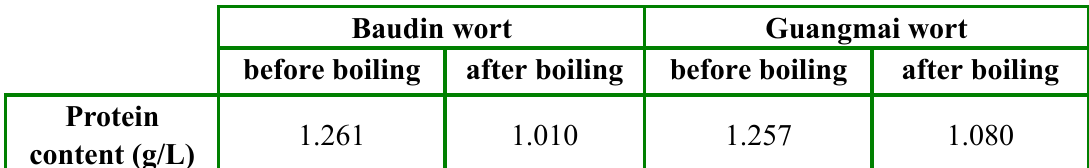
Table 1 . Changes of protein contents of the worts during the boiling step a